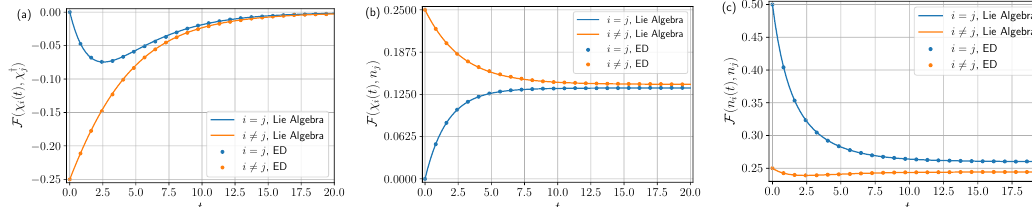
) in (a), F ( χ ( t ) , n ) in (b) and F ( n ( t ) , n ) in (c) vs i j i j j